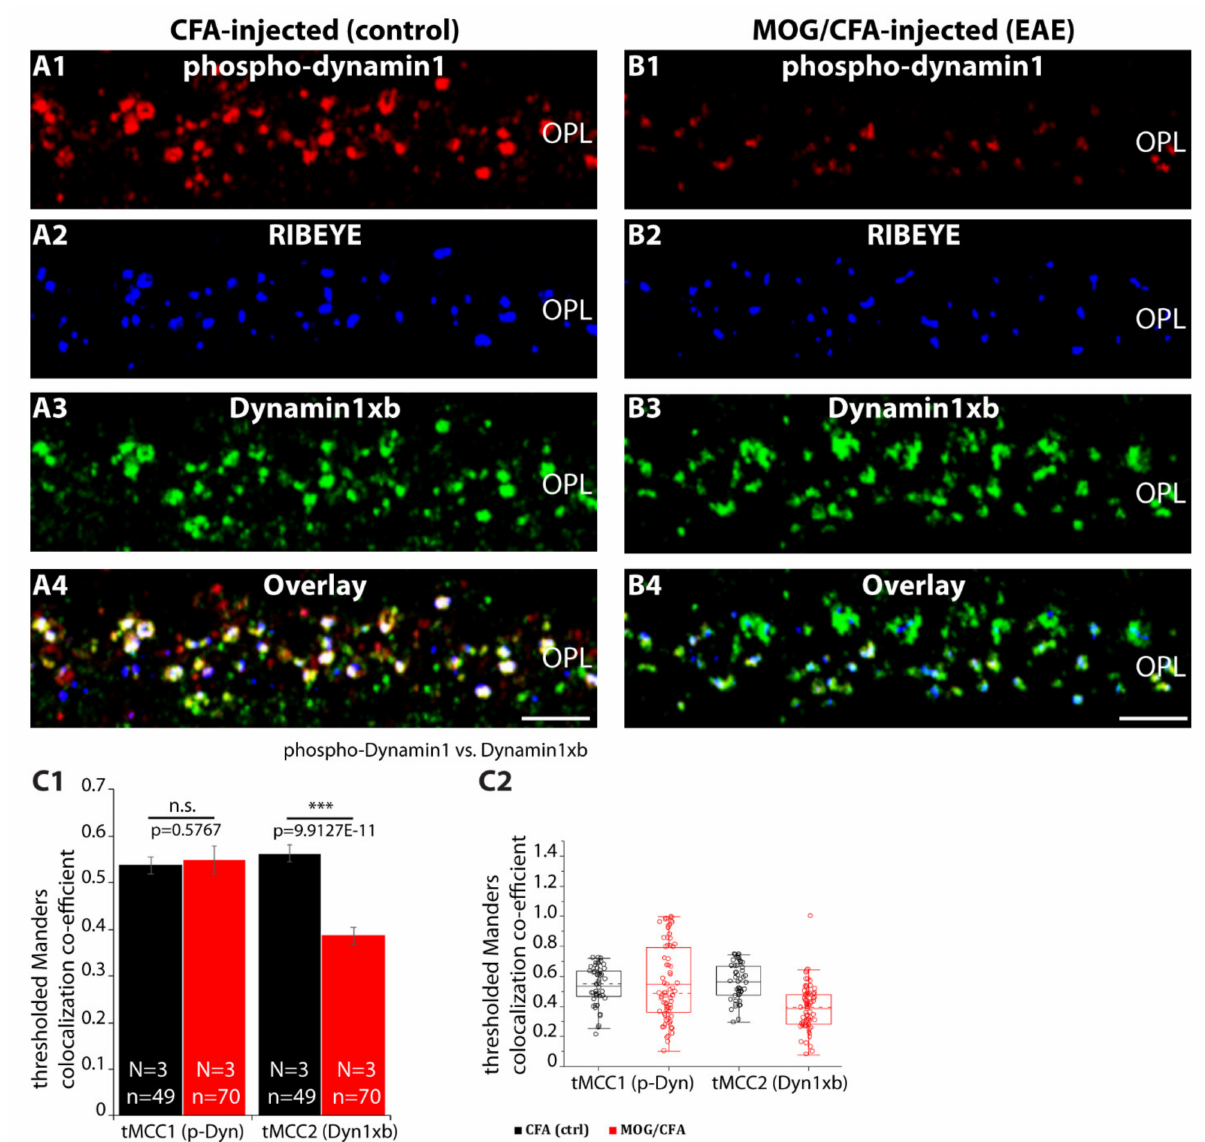
Figure 13. Triple immunolabelling of retinal semithin section from CFA-injected control and MOG/CFA-injected EAE mice. ( A1 – B4 ) 0.5 µ m semi-thin sections from CFA-injected (control) mice and MOG/CFA-injected EAE mice were triple- immunolabelled with sheep polyclonal anti-p-dynamin1, rabbit polyclonal anti-RIBEYE (U2656), and mouse monoclonal anti-dynamin1xb. ( C ) Manders colocalization coefficients show the degree of colocalization between p-dynamin1 and dynamin1xb in the photoreceptor ribbon synapse in the OPL of CFA-injected control mice and MOG/CFA injected EAE mice. Values in ( C1 ) are means ± S.E.M. In the box-and-whisker plots ( C2 ) of the data from ( C1 ), mean value are represented by solid horizontal lines; median by dotted horizontal lines. Boxes represent the 25th–75th percentile of the data points and whiskers are equal to 1.5 times of the IQR. Mann–Whitney U-test was used to determine the statistical significance because data were non-normally distributed in ( C1 , C2 ). Abbreviations: OPL, outer plexiform layer; N, number of mice; n, number of confocal images used for colocalization analysis; ***, p ≤ 0.001; tMCC, thresholded Manders colocalization co-efficient. Scale bars: 5 µ M ( A4 , B4